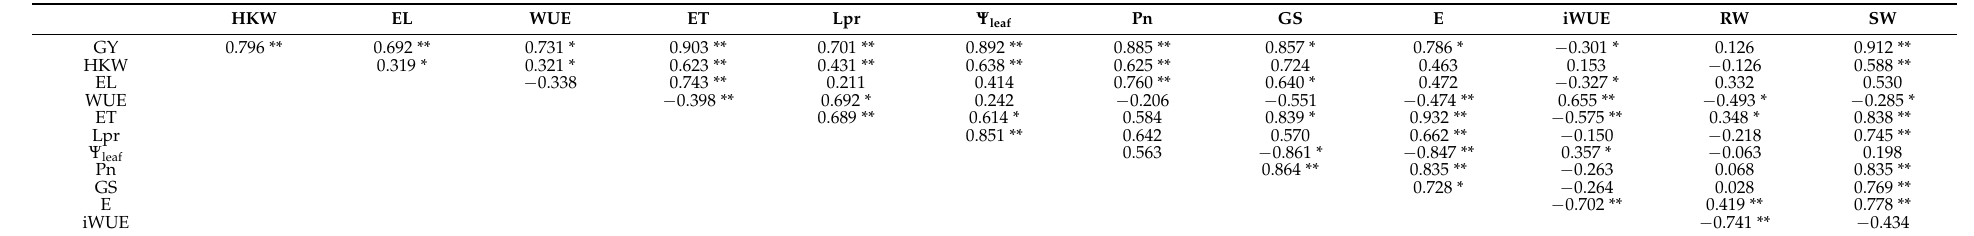
Table 3. Correlations among yield, yield components, and physiological indices under well-watered (WW) and drought stress (WS) conditions. HKW EL WUE